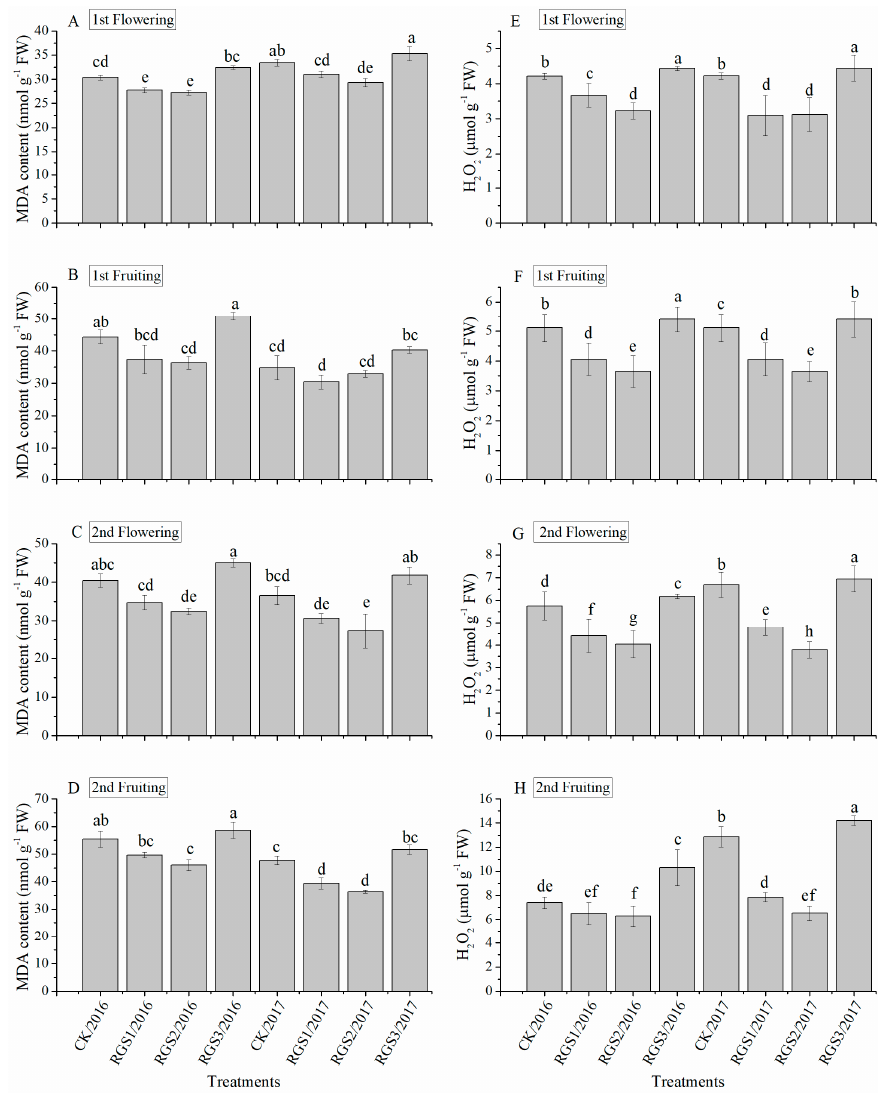
Figure 6. Effect of amendment with raw garlic stalk on plant stress indicators. Malondialdehyde (MDA) ( A ) 1st flowering, ( B ) 1st fruiting, ( C ) 2nd flowering and ( D ) 2nd fruiting, hydrogen peroxide (H 2 O 2 ) contents ( E ) 1st flowering, ( F ) 1st fruiting, ( G ) 2nd flowering and ( H ) 2nd fruiting. The error bars represent standard error of the means ( n = 3). Different letters between treatments at different sampling stages show significant difference at p < 0.05 level (ANOVA and LSD).